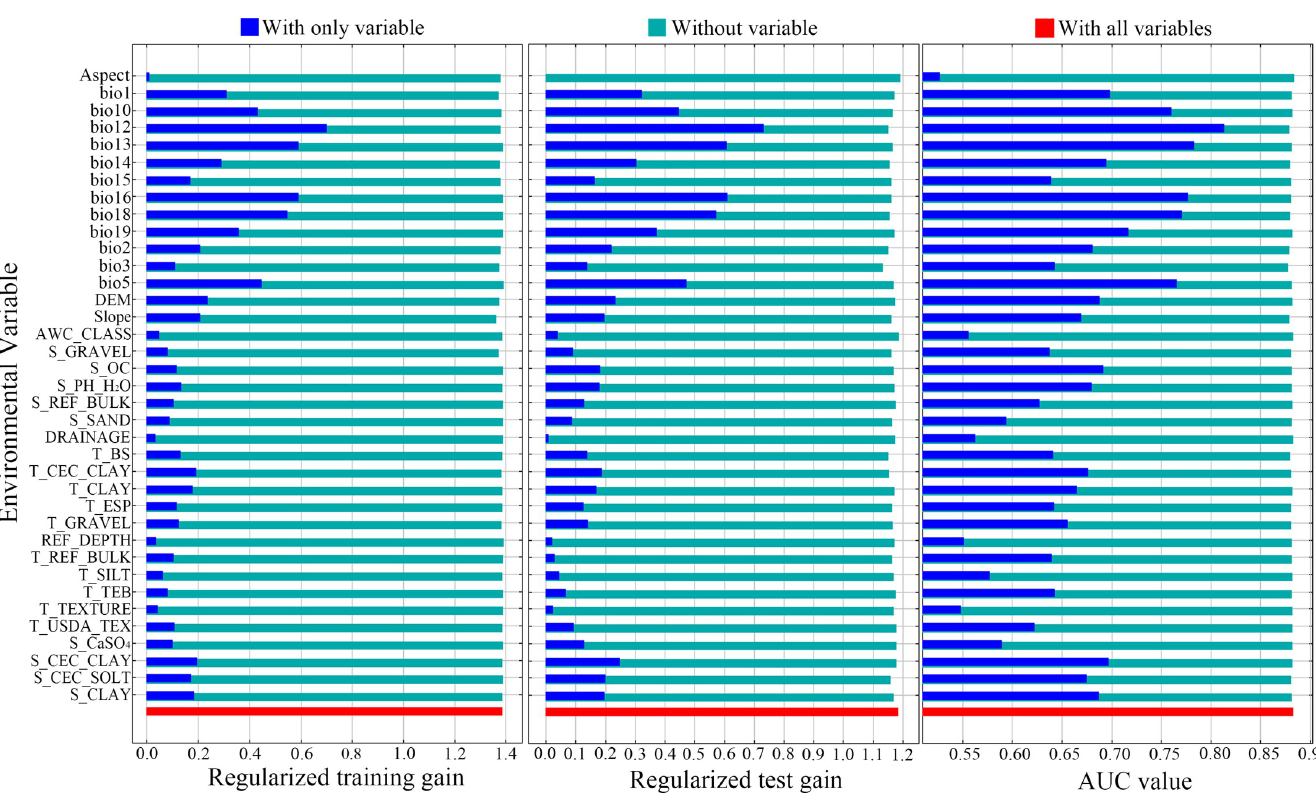
Fig 2. Results of the Jackknife test of environmental variables’ contribution in Betula platyphylla Suk.’s potential geographical distribution. The figure shows the result of the Jackknife test of variable importance using regularized training gain, regularized test gain, and AUC value on test data respectively. The blue bars indicate the gain using the solo environmental variable, the green bars indicate the gain excluding the single variable from the full model, and the red bars indicate the gain considering all variables.